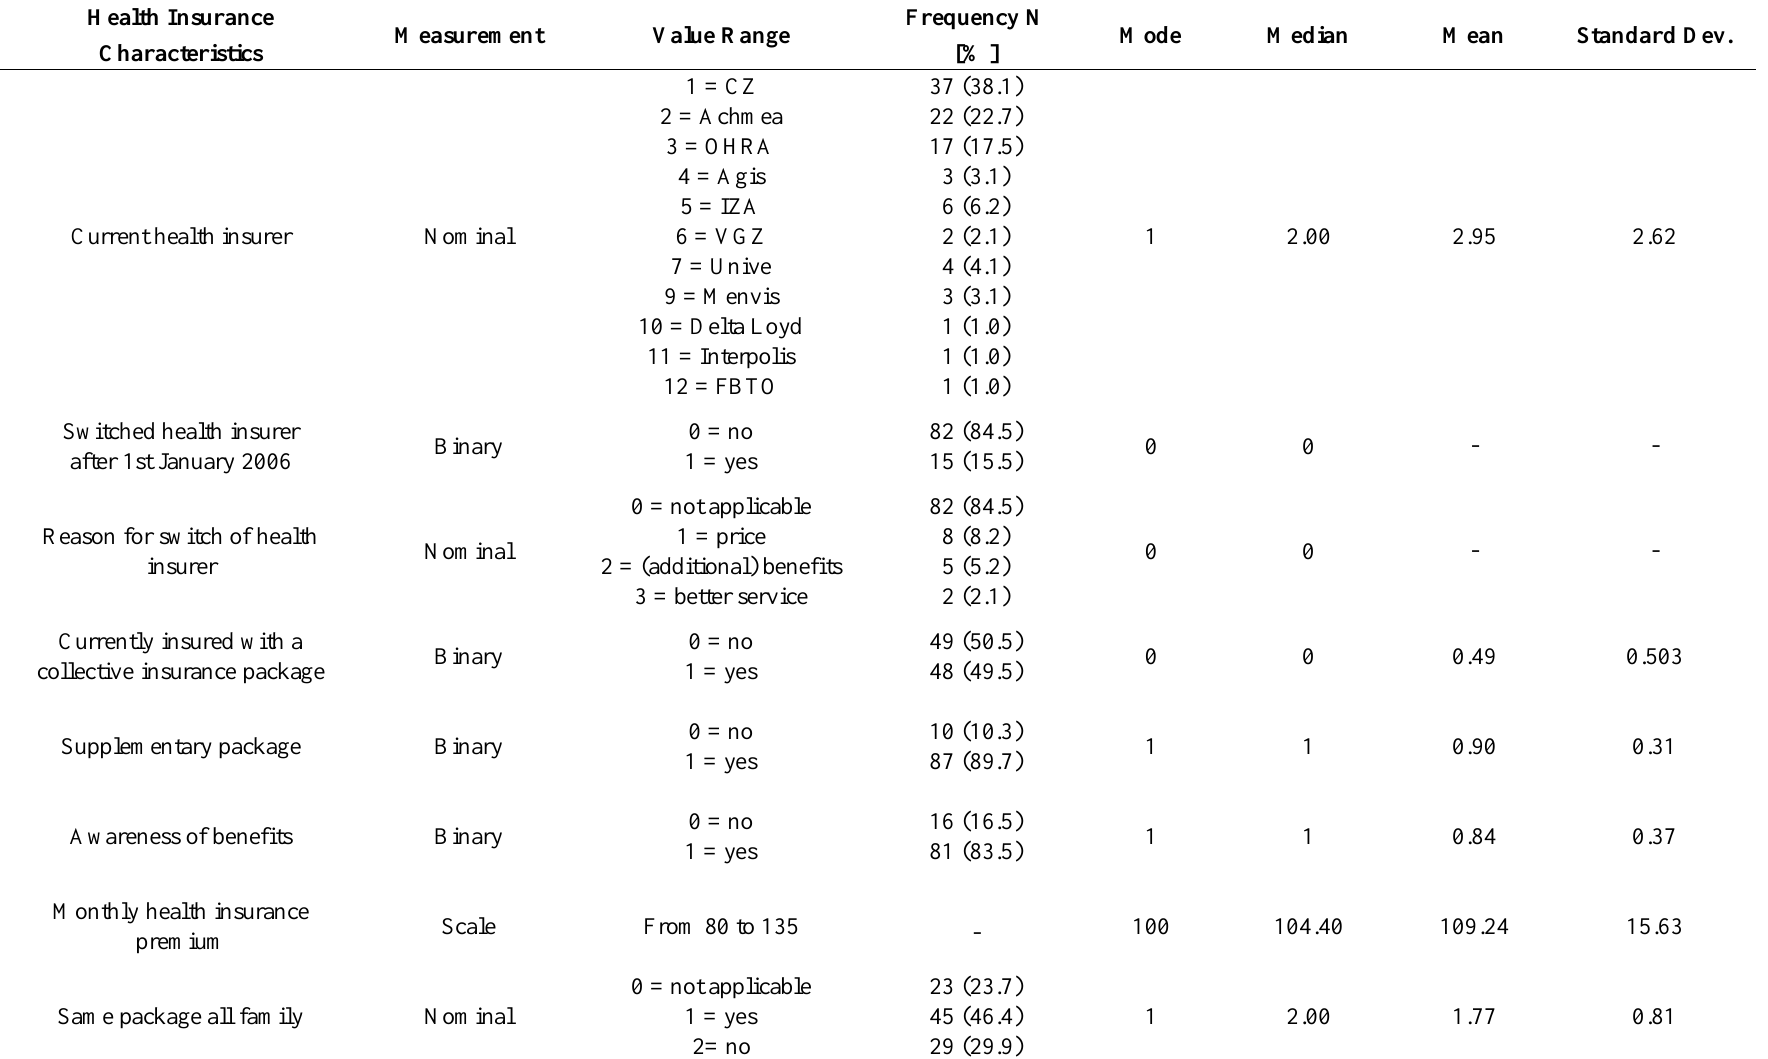
Table 4. Health insurance status of the respondents a